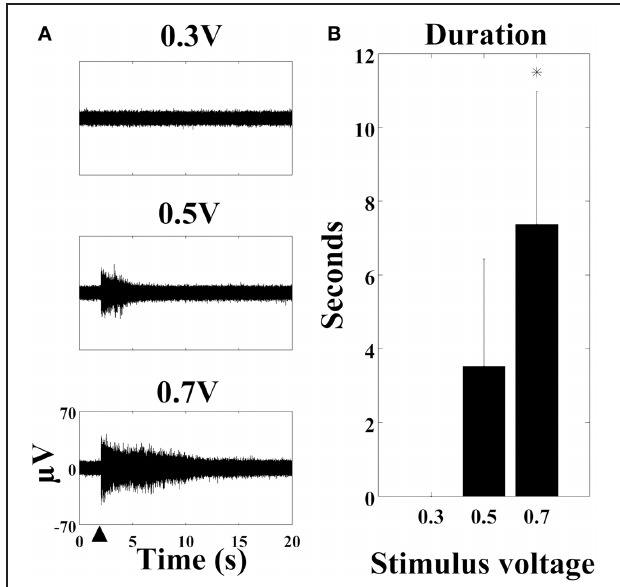
FIGURE 3 | The stimulus-evoked oscillation is voltage-dependent. (A) SALPA filtered recordings (cortical culture age six weeks) with stimulus of 0.3V, 0.5V, and 0.7V at the large black arrowhead. (B) The duration in seconds of the oscillation is longer with higher voltages ( n = 57 electrodes from four cultures: one cortical and three hippocampal, ∗ p < 0 . 001). 1 μ M TTX was present in the medium. Error bars: standard